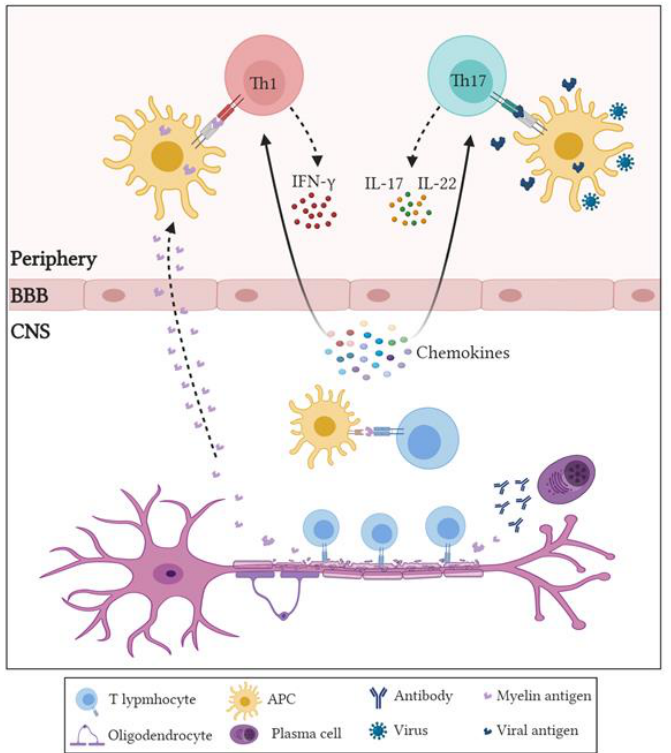
Figure 1. Involvement of various immune players in the pathogenesis of multiple sclerosis. There are two main hypotheses for the initial triggering of MS autoimmune response: either infectious antigens (mostly viral) that have molecular similarity (mimicry) with CNS antigens are engulfed by dendritic cells (DCs) or macrophages and presented to CD4 + T cells in the periphery, or stress such as inflammation, genetics, and some environmental factors cause damage to the myelin protein of the axons, releasing myelin antigens that bypass the blood–brain barrier (BBB) and induce an autoimmune response in the periphery. These events activate CD4 + T cells, which produce inflamma- tory cytokines and differentiate into Th1 that produce IFN- γ , or T helper 17 (Th17) cells producing interleukin 17 (IL-17) or interleukin 22 (IL-22), which permeabilize the BBB. Released